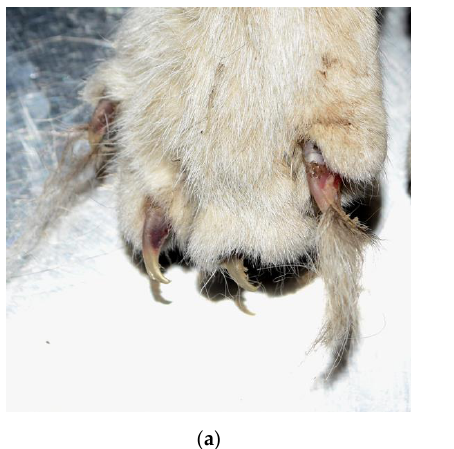
Figure 5. Broken claws with entrapped hair remains in the right forelimb of a cat. ( a ) Long, white hair remains entrapped in the broken claws of a cat. The cat was short-haired and had a tabby and white coat color. ( b ) Sampled broken claws with entrapped hair remains. The hair remains tested positive for canine mitochondrial DNA (Case 4).